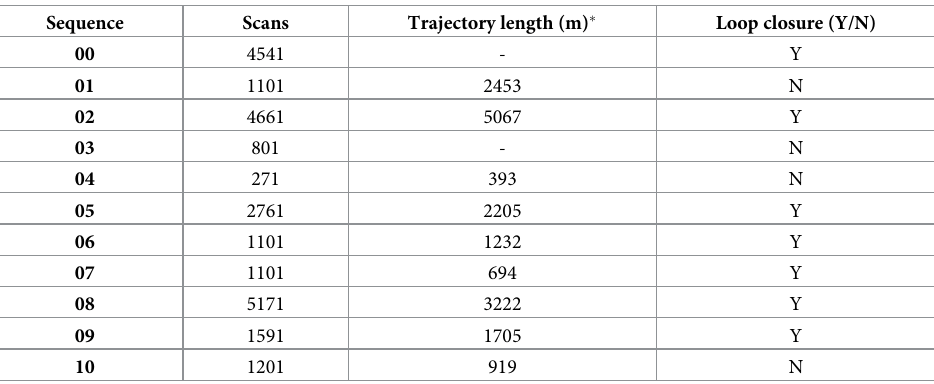
Table 1. KITTI dataset